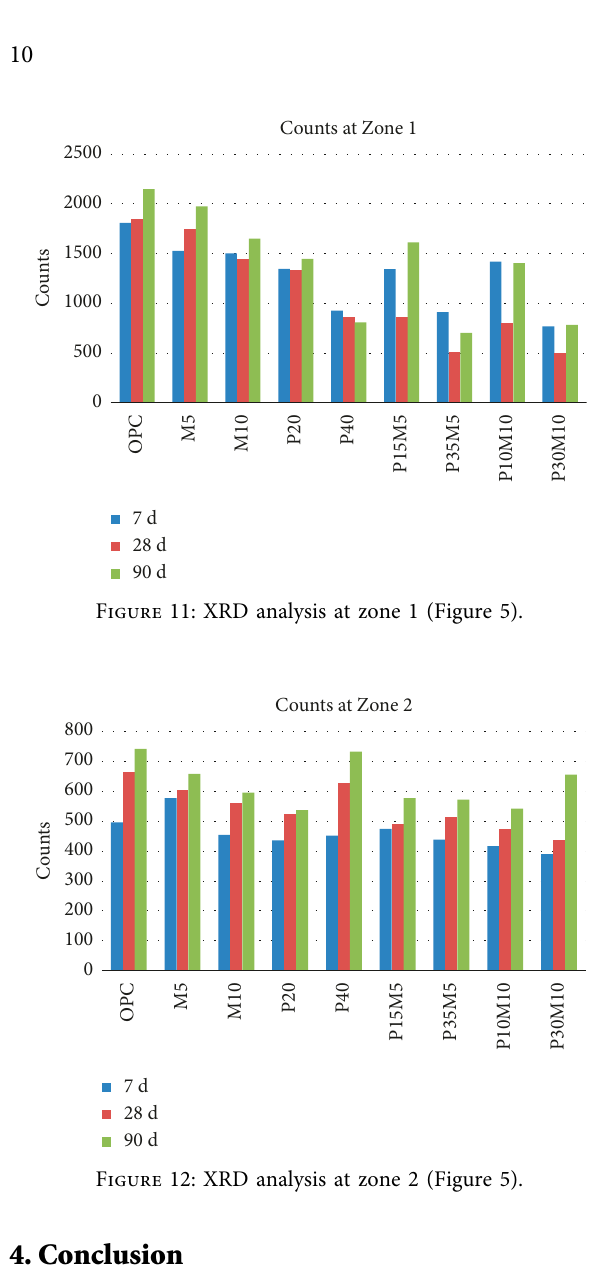
Figure 12: XRD analysis at zone 2 (Figure